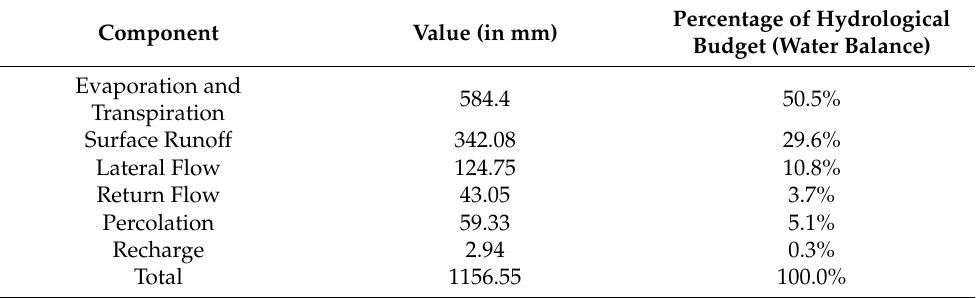
Table A8. Components of the hydrologic budget and water balance of the James River